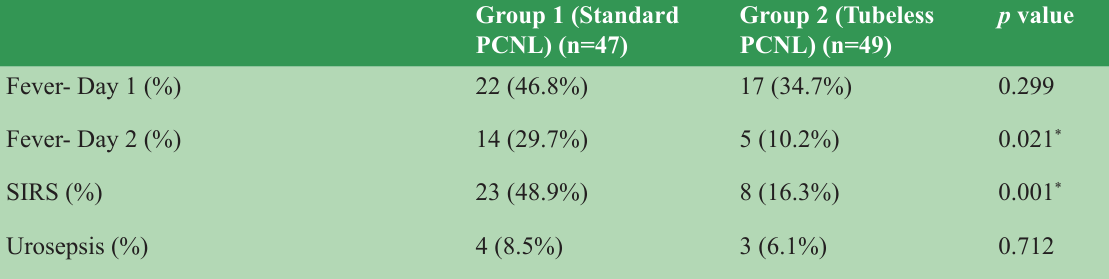
Table 2: Post operative fever, SIRS and Urosepsis following